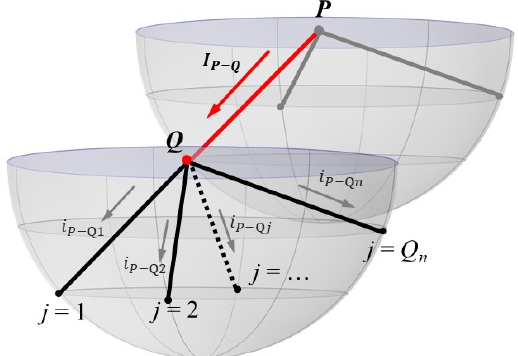
Figure 14. The shunt process of lightning current in branches.